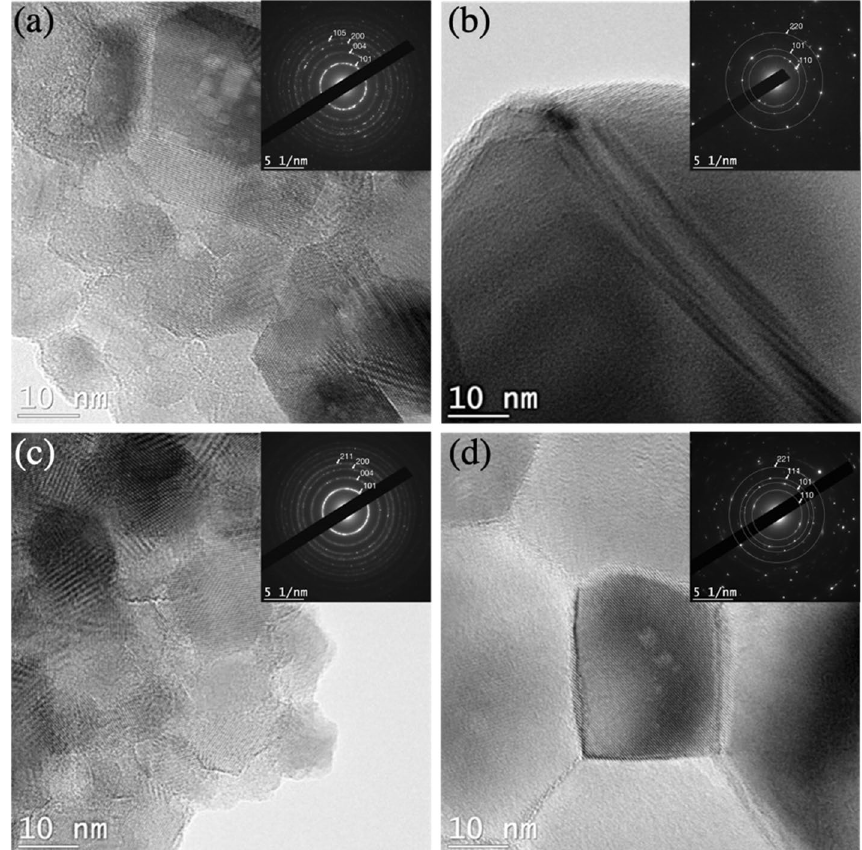
TiO 2 obtained at 450ºC. ( b ) Standard (white) rutile TiO 2 obtained at 800ºC. ( c ) Defect-rich (red) anatase TiO 2 obtained at 450ºC. ( d ) Defect-rich (red) rutile TiO 2 at